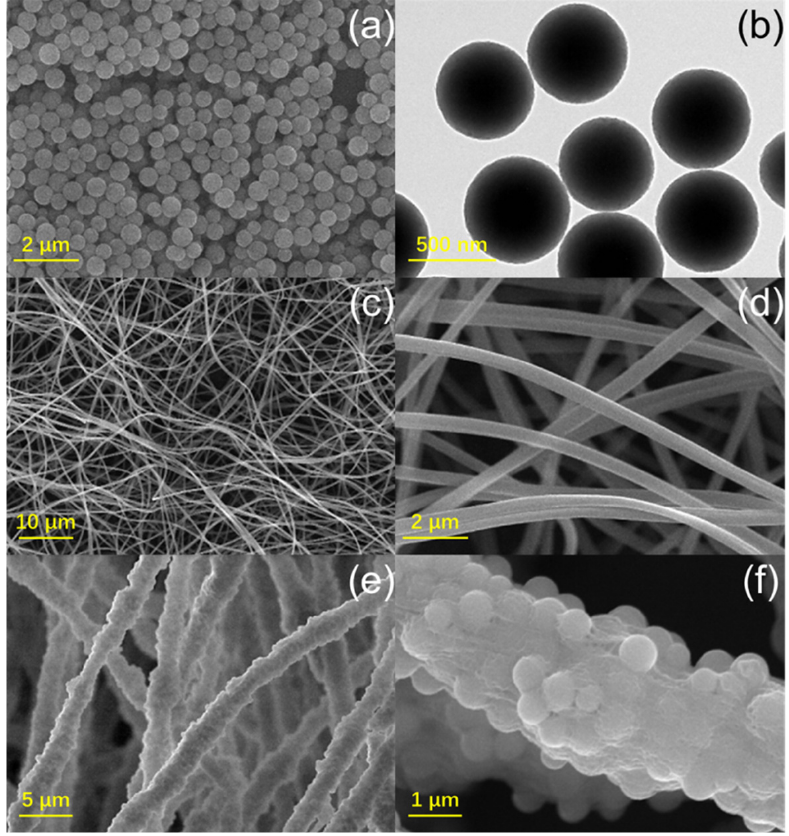
Figure 1. SEM ( a ) and TEM ( b ) images of APNs; SEM images of PAN ( c , d ) and PAN/APNs ( e , f ).